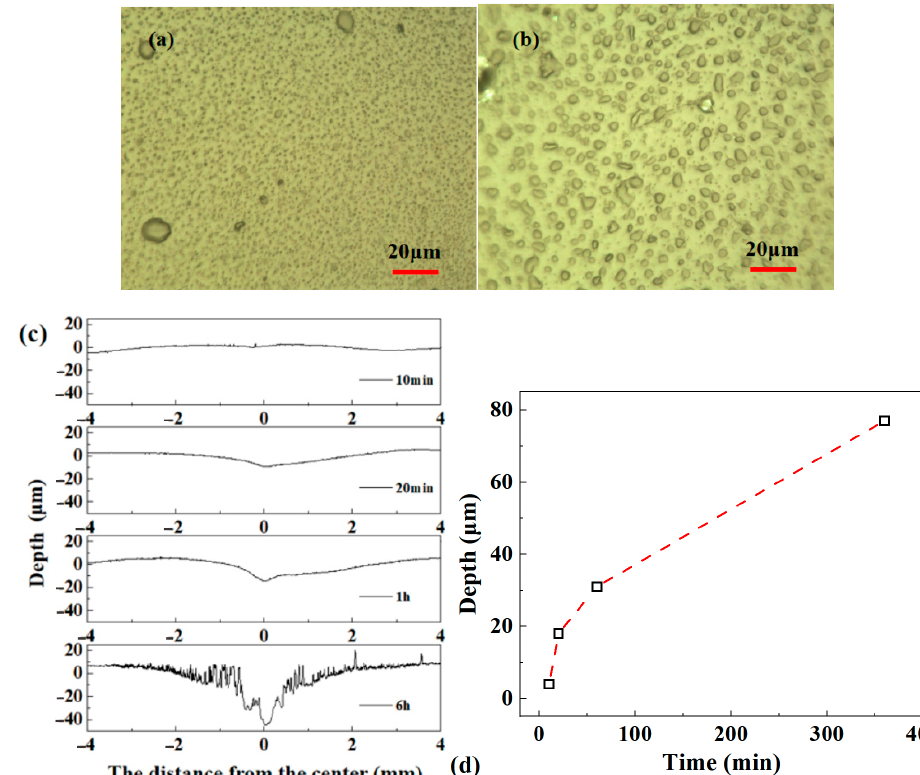
Figure 11. Surface morphology after erosion under bipolar square-wave voltage: ( a ) surface picture after 10 min erosion; ( b ) surface picture after 20 min erosion; ( c ) surface contour curve; ( d ) erosion rate at the center position.